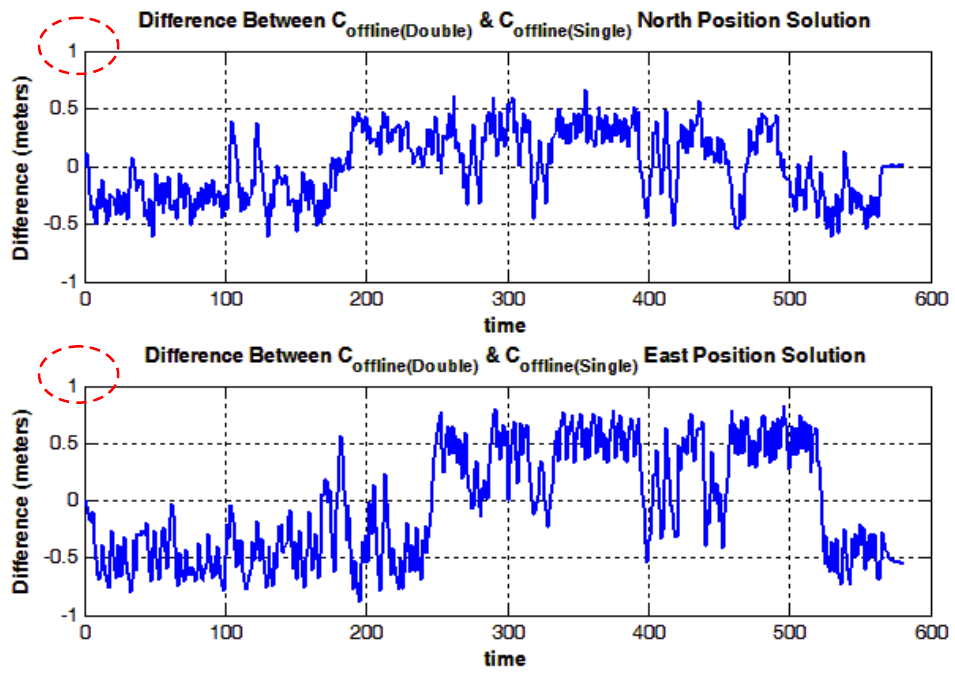
Figure 13. Mobile Robot Trajectory (1): Difference between C Double-Precision Offline and C Single-Precision Offline